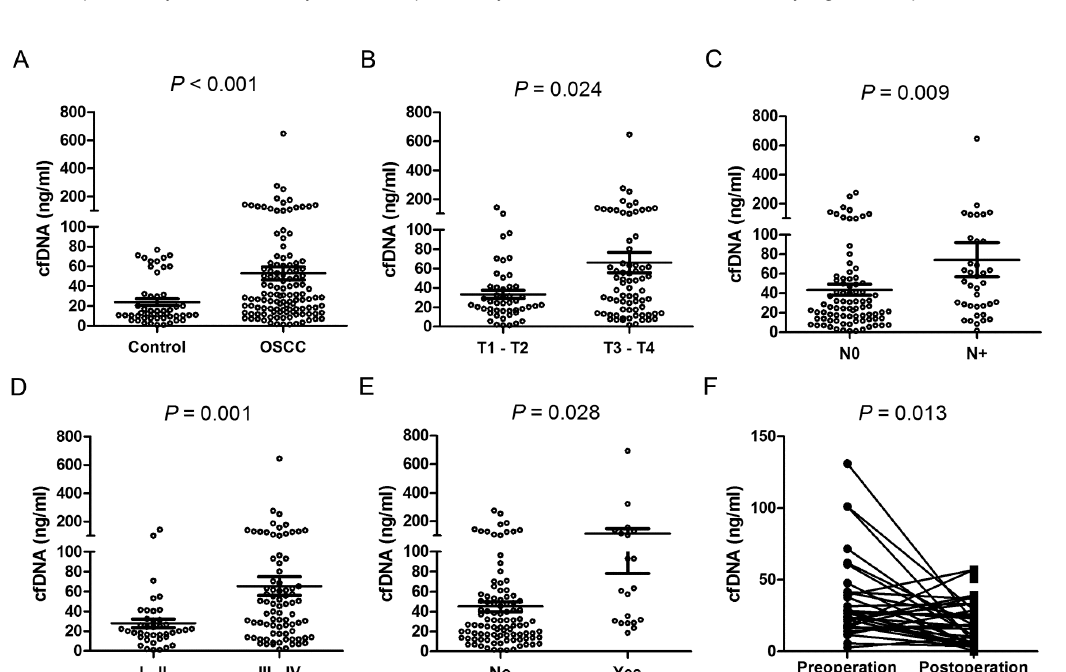
Table 2. Association between cfDNA content and OSCC risk.